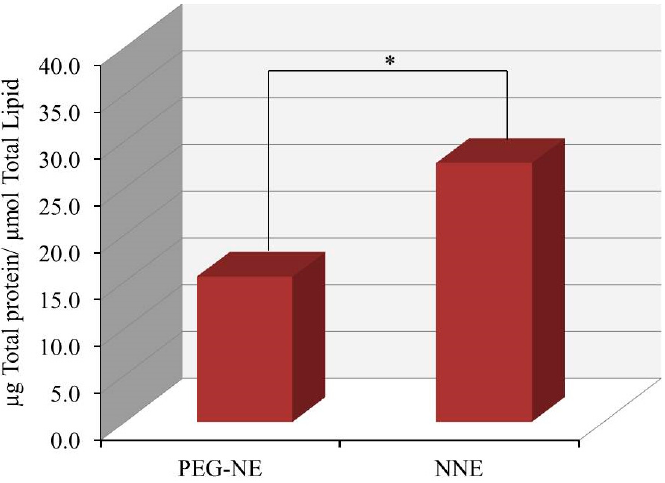
Figure 8. Total quantity of serum proteins adsorbed on NNE and PEG ‐ NE surface. Results are stated as the mean with the bar showing S.D. ( n = 3). * p < 0.05 if compared to naked counterpart.